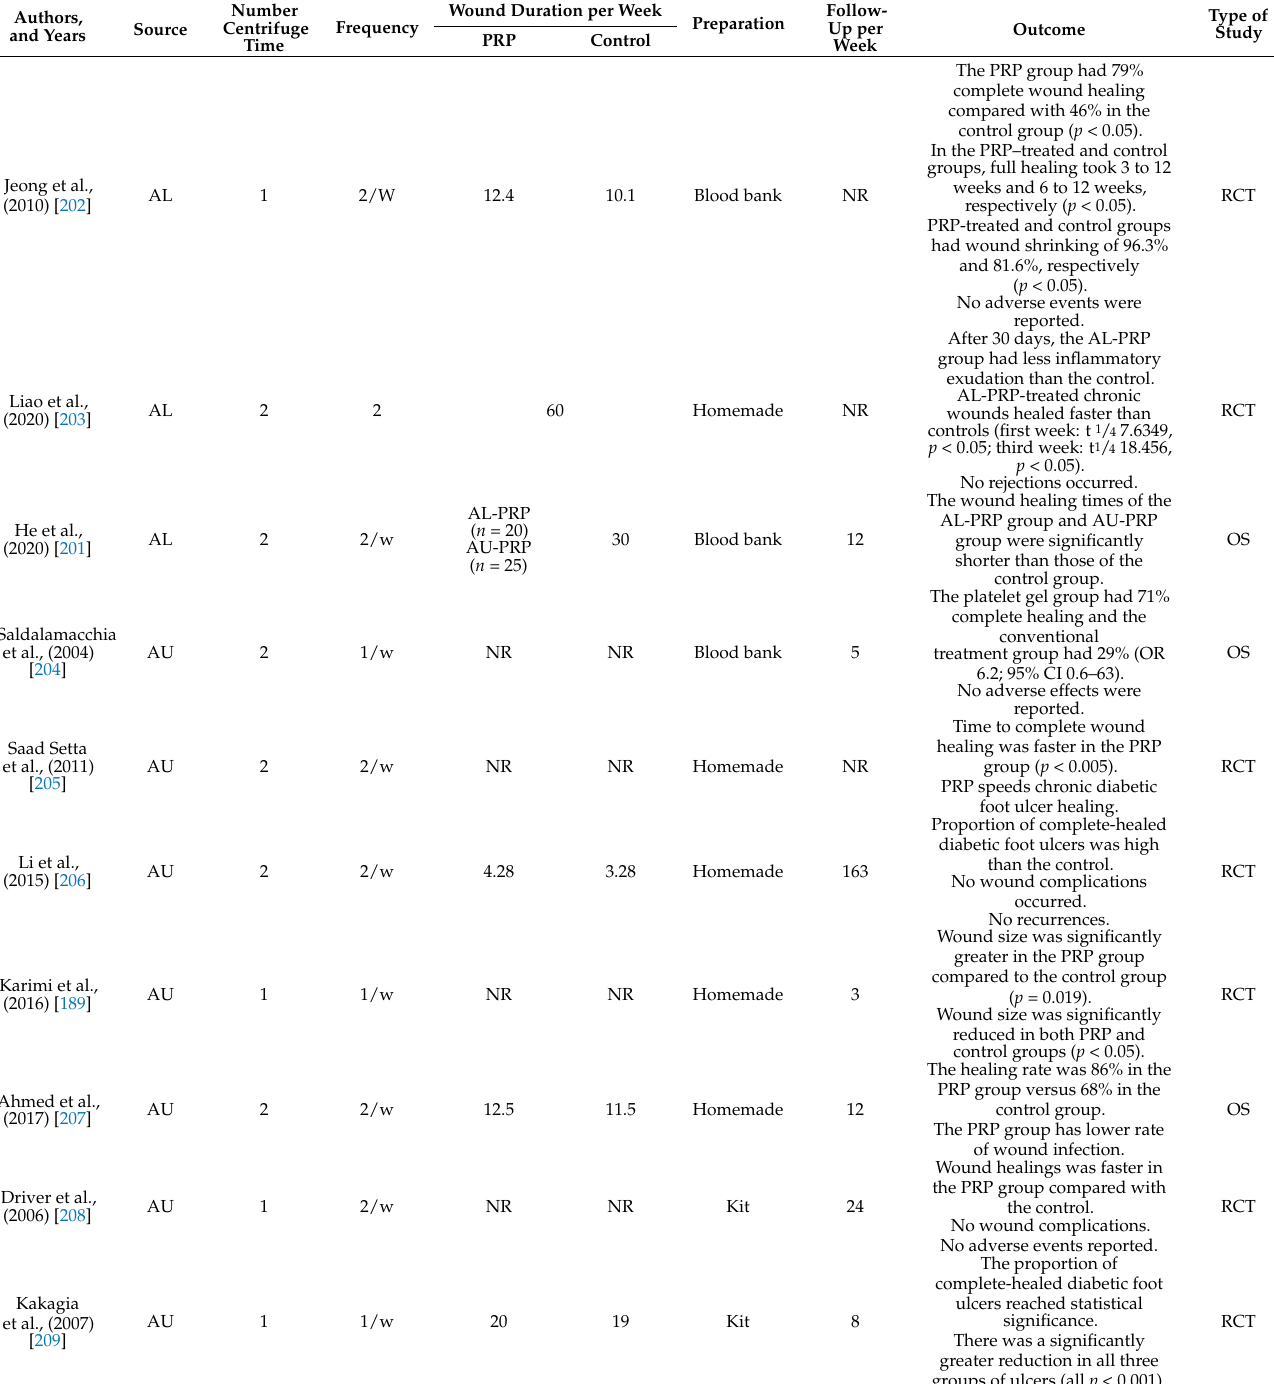
Table 5. Studies on the use of PRP application in foot and ankle for diabetic foot ulcer and wound